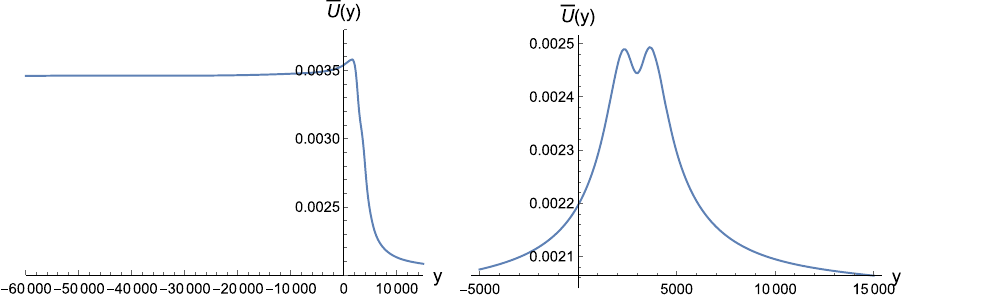
Fig. 1 There are two types of the effective potentials (in the tortoise function with a bump on the top. The right has ω = 0 . 0496 and the coordinate). For example, we fix parameters ( m p , q 1 , q 2 ,(cid:11), Q 1 , Q 2 ) = potential has double peaks. It is the latter volcano-shaped potential that ( 0 . 045 , 0 . 025 , 0 . 025 , 1 , 1 , 100 ) and ( N , N ) = ( 2 , 2 ) . The left panel gives rise to unstable QNMs 1 2 has ω = 0 . 0598 and the potential has a single peak. It is like a step